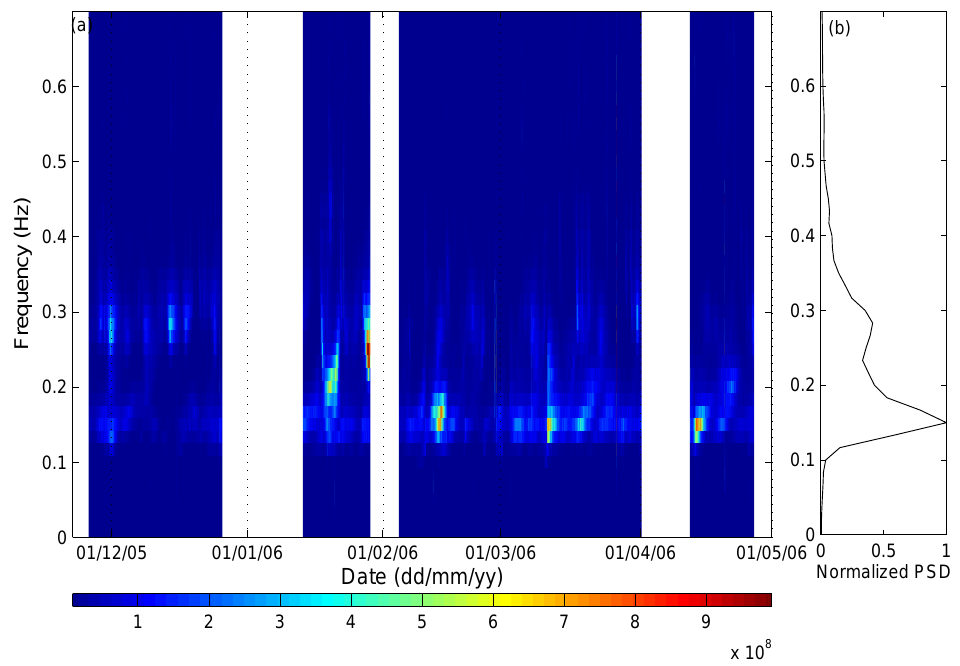
Fig. 12. (a) Spectrogram of the background seismic signal of the Colima volcano between 0.1 and 0.5Hz. (b) Mean normalized power spectra obtained by averaging the spectra computed from 60s time-windows over the complete data-set and dividing by the maximum value. The figure is contained in Cusano and Palo (2011).